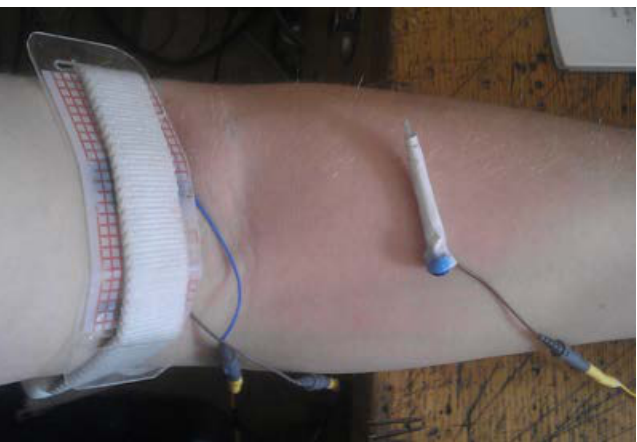
Figure 5. The experimental setup.